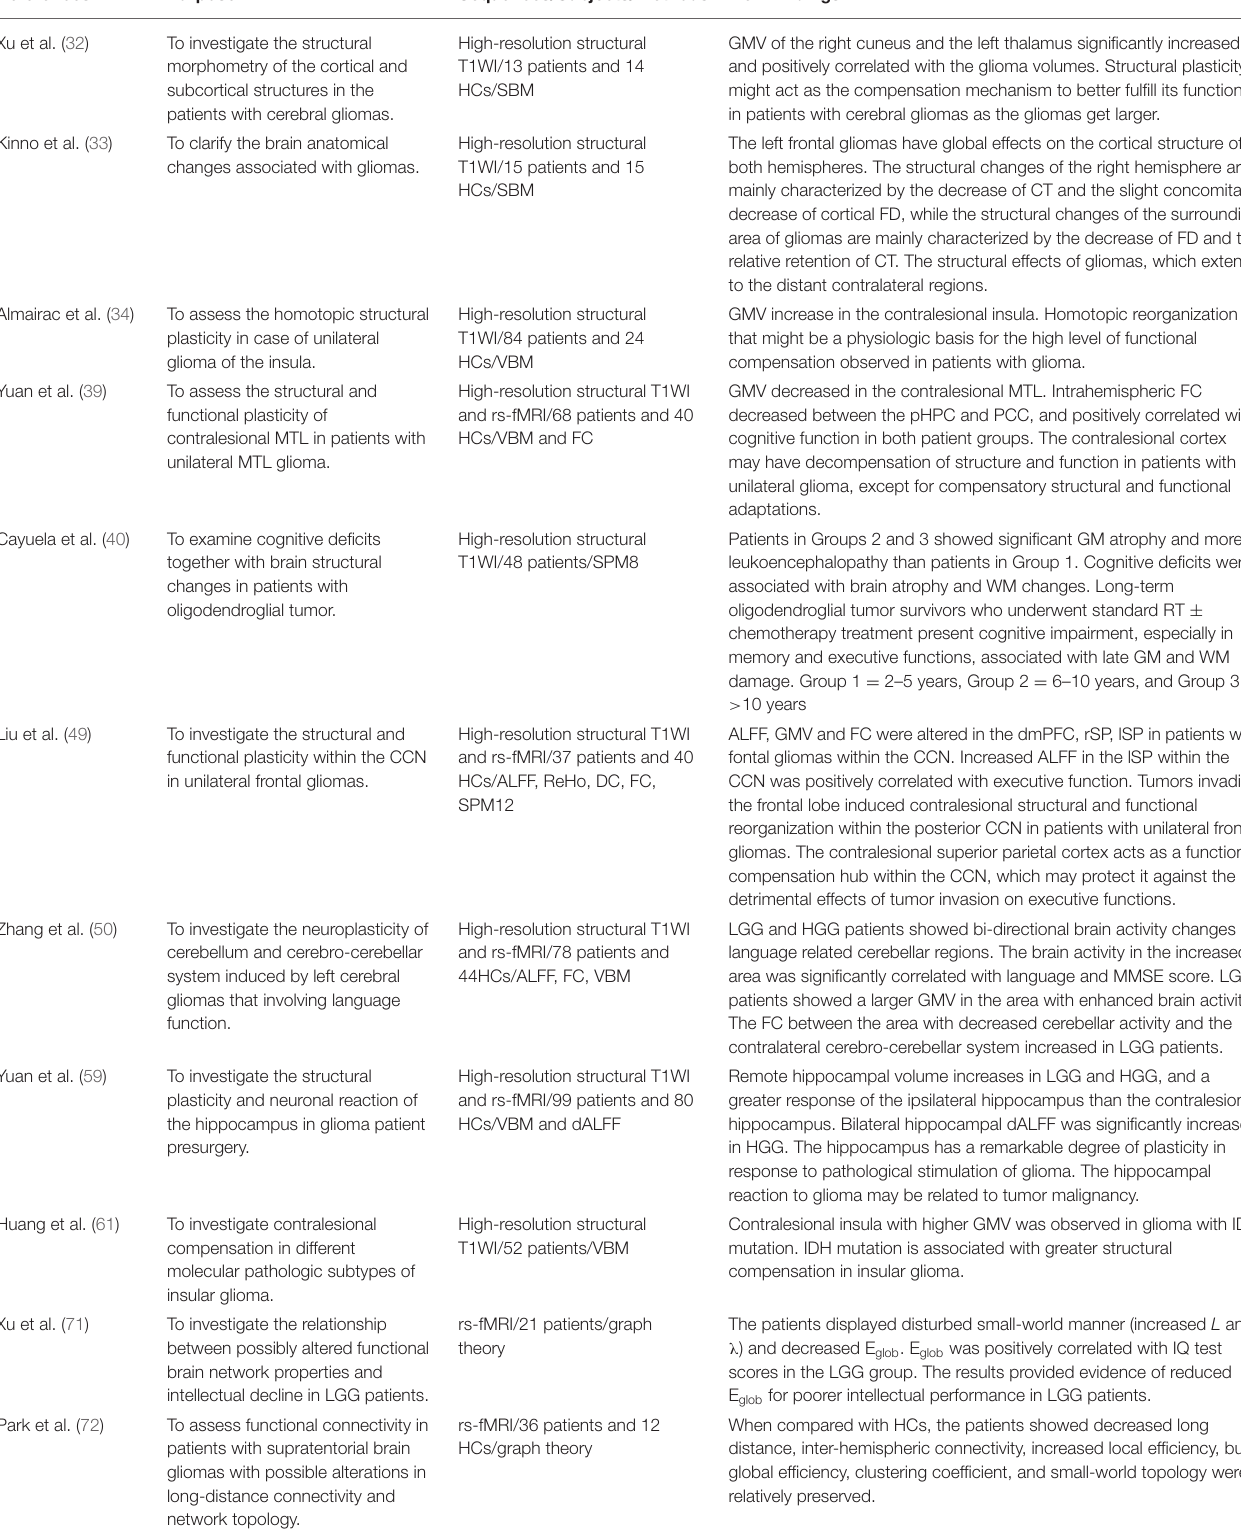
TABLE 1 | Studies on the neuroplasticity of the structural and topological network in glioma